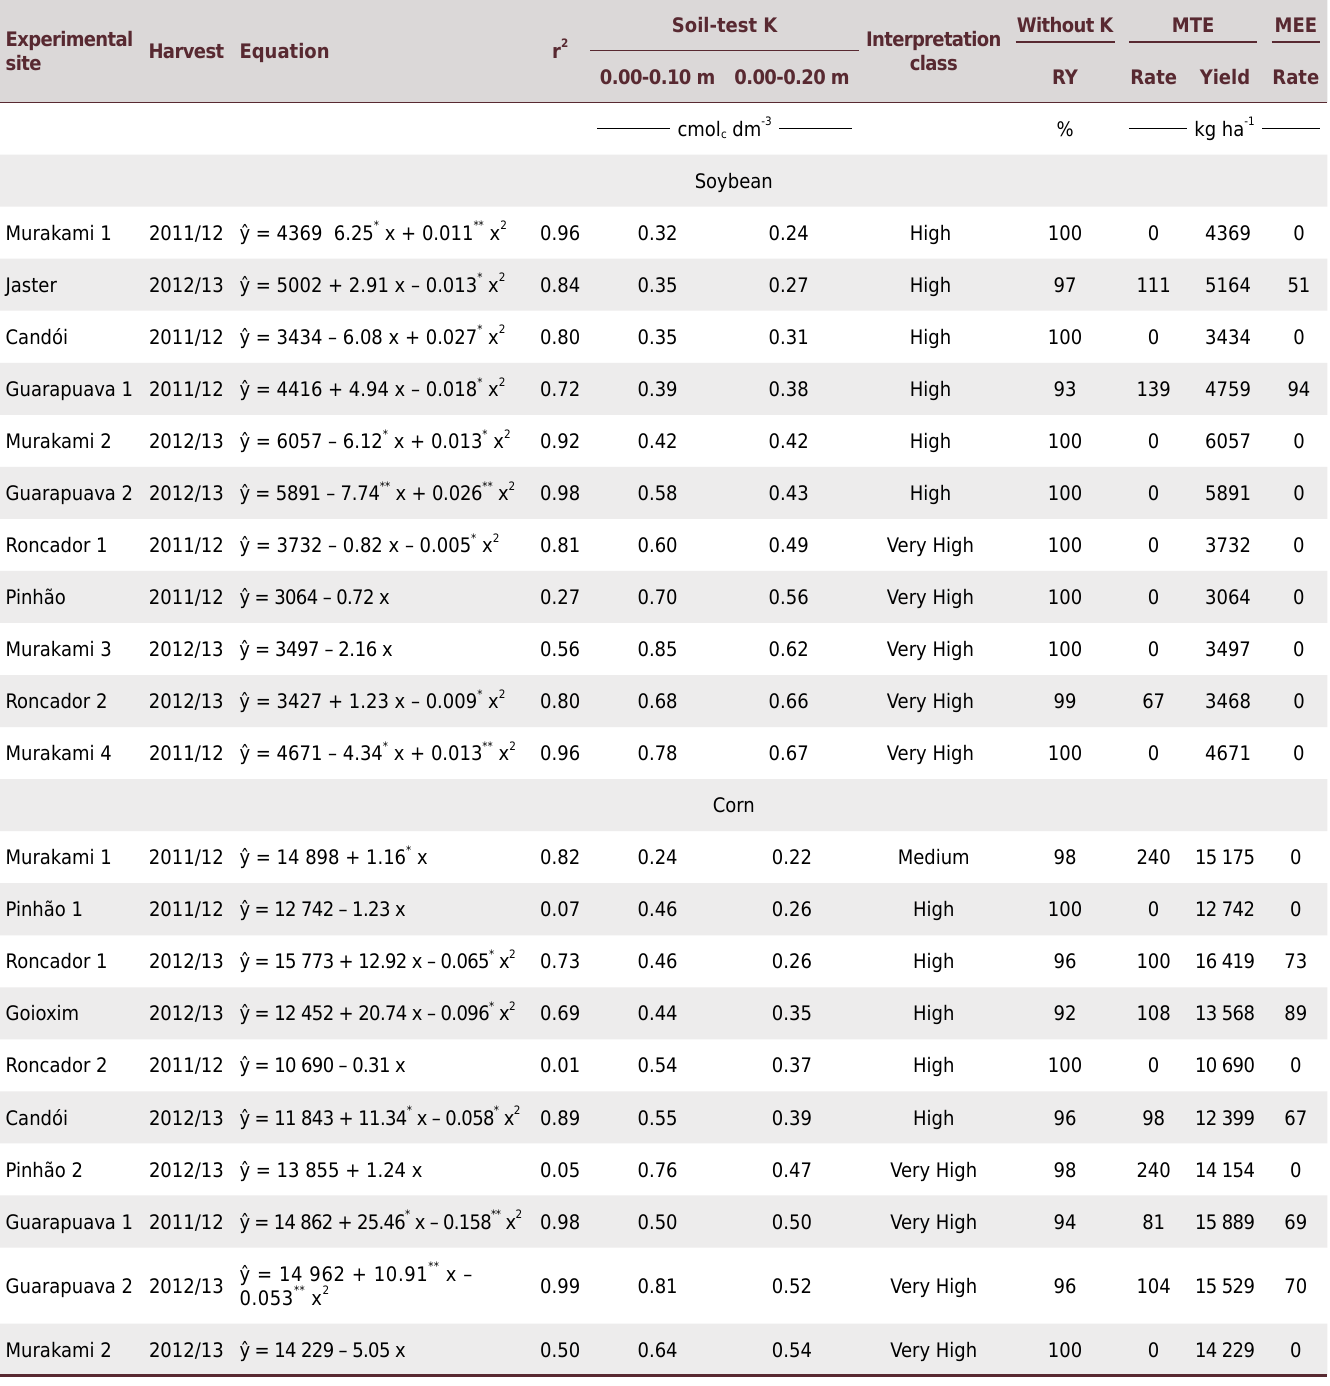
Table 2. Soil-test K values at two soil depths, fitted equations for soybean and corn yields as a function of K rate, relative yield in the treatment without K, maximum technical efficiency (MTE) rate, and maximum economic efficiency (MEE) rate in different crops and sites Experimental Harvest site